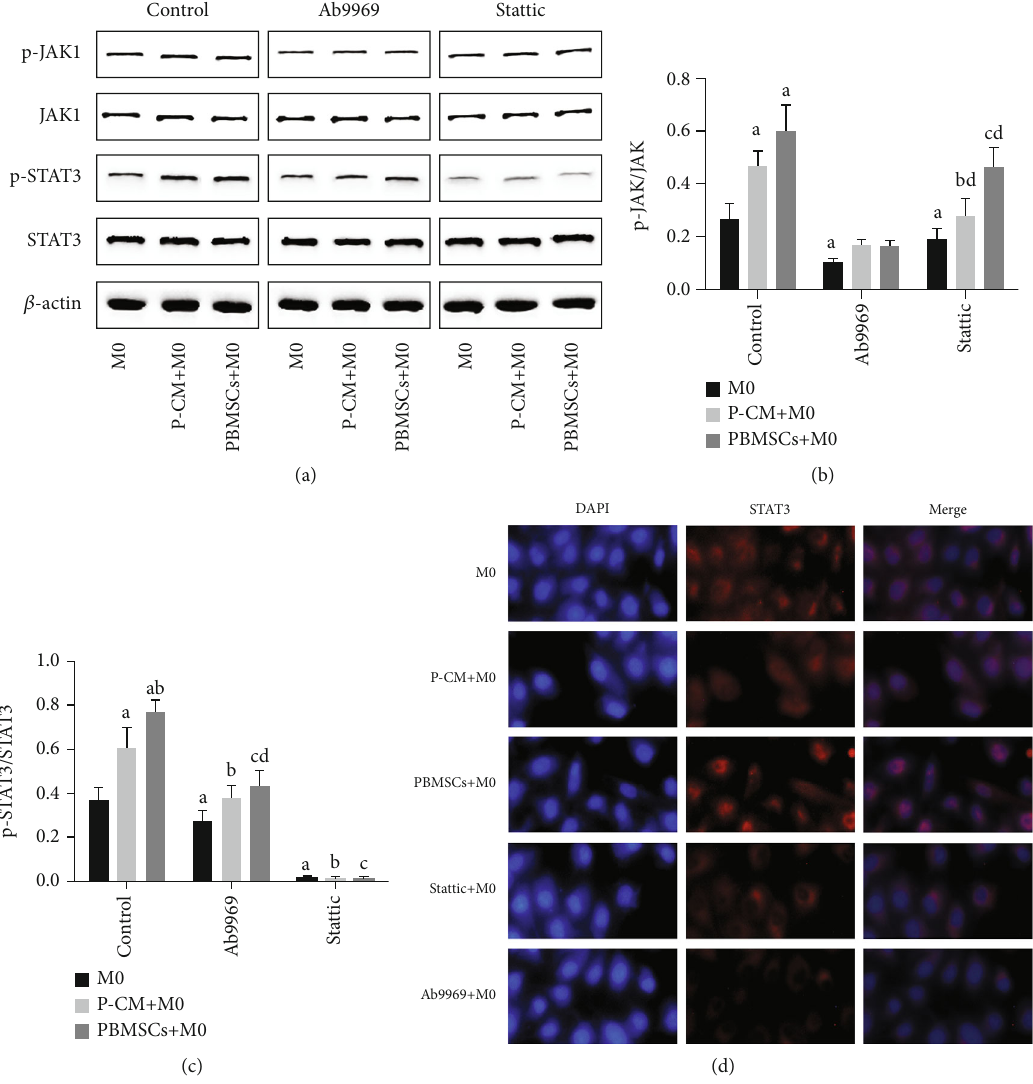
Figure 5: Phosphorylation of JAK1 and STAT3 proteins in various culture groups. (a) WB results of JAK1/p-JAK1, STAT3/p-STAT3, and β -actin. (b) Phosphorylation states of JAK1 in various culture groups. (c) Phosphorylation states of STAT3 in various culture groups. (d) Intracellular distribution of STAT3 (red) in macrophages; DAPI: nuclear staining (blue). Graphs show the mean ± standard deviation ; n =